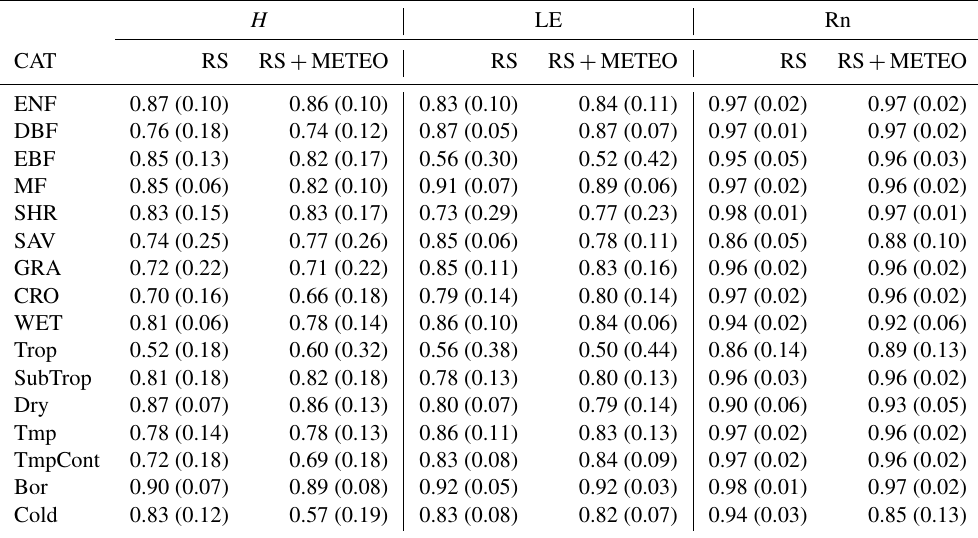
Table C4. Median site-by-site R 2 and its standard deviation (in parentheses and estimated as reported in Jung et al., 2009) for the energy fluxes per PFT and climate zones. List of acronyms: ENF, was evergreen needleleaf forest; DBF, deciduous broadleaf forest; EBF, evergreen broadleaf forest; MF, mixed forest; SHR, shrubland; SAV, savannah; GRA, grassland; CRO, cropland; WET, wetland; Trop, tropical; Sub- Trop, subtropical; Dry, dry and arid land; Tmp, temperate; TmpCont, temperate–continental; Bor, boreal; Cold, cold and polar environment or covered by